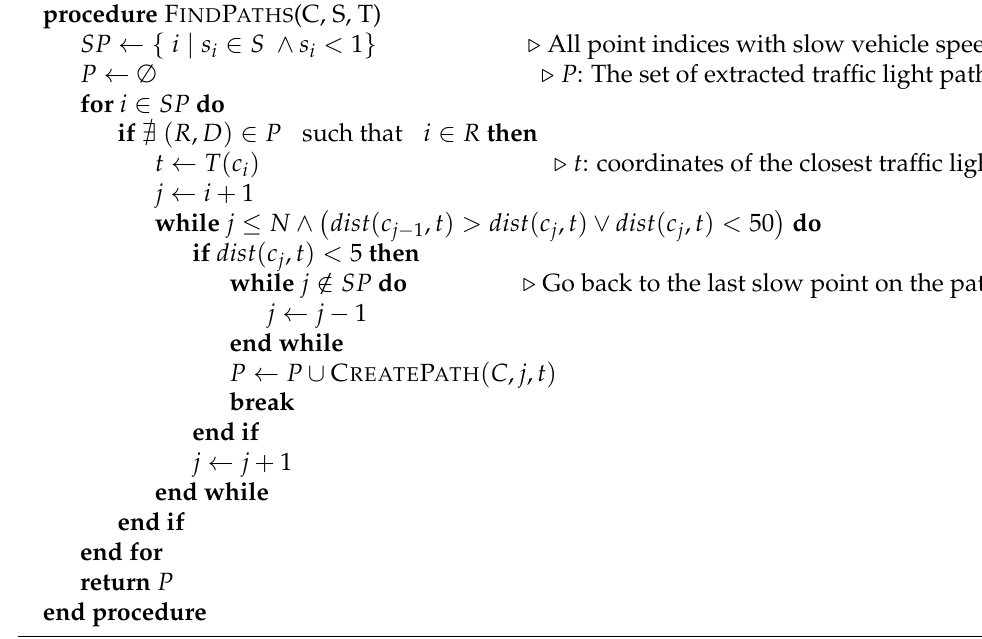
Algorithm 1 Finding the set of paths before stopping at red traffic lights during a day for a vehicle